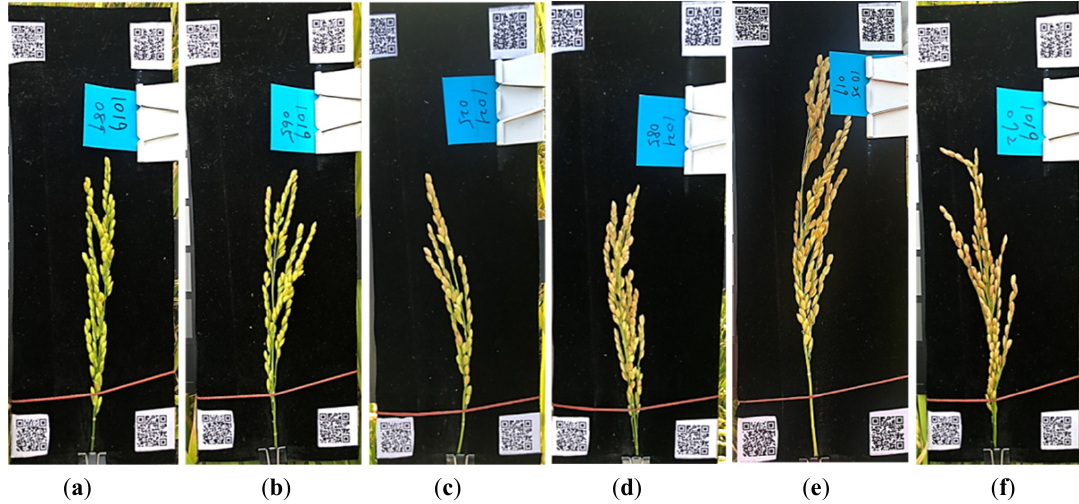
Figure 6. The phenotype transformation of single panicles from green to yellow with moisture content (% w.b. ): ( a ) 51, ( b )